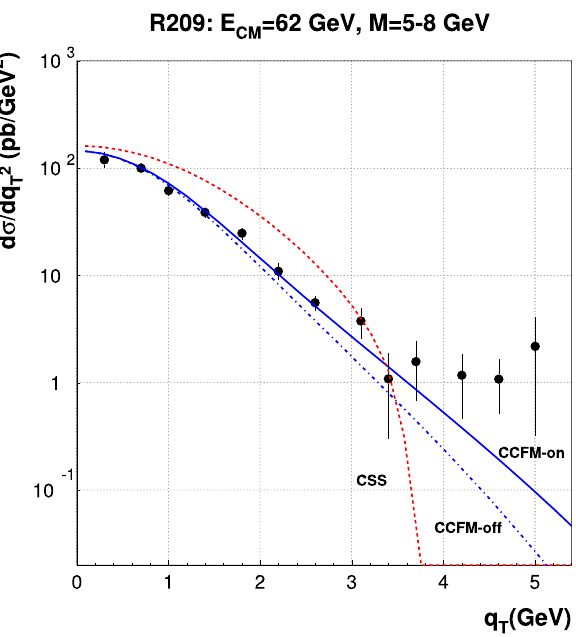
Fig. 4 Transverse momentum dependence of the DY cross sections: datafromproton–protonR209experimentarecomparedwithCCFM-K on-shell cross section (47) (solid line), CCFM-K off-shell cross section (56) (dash-dotted line) and CSS cross section (59) (dashed line)